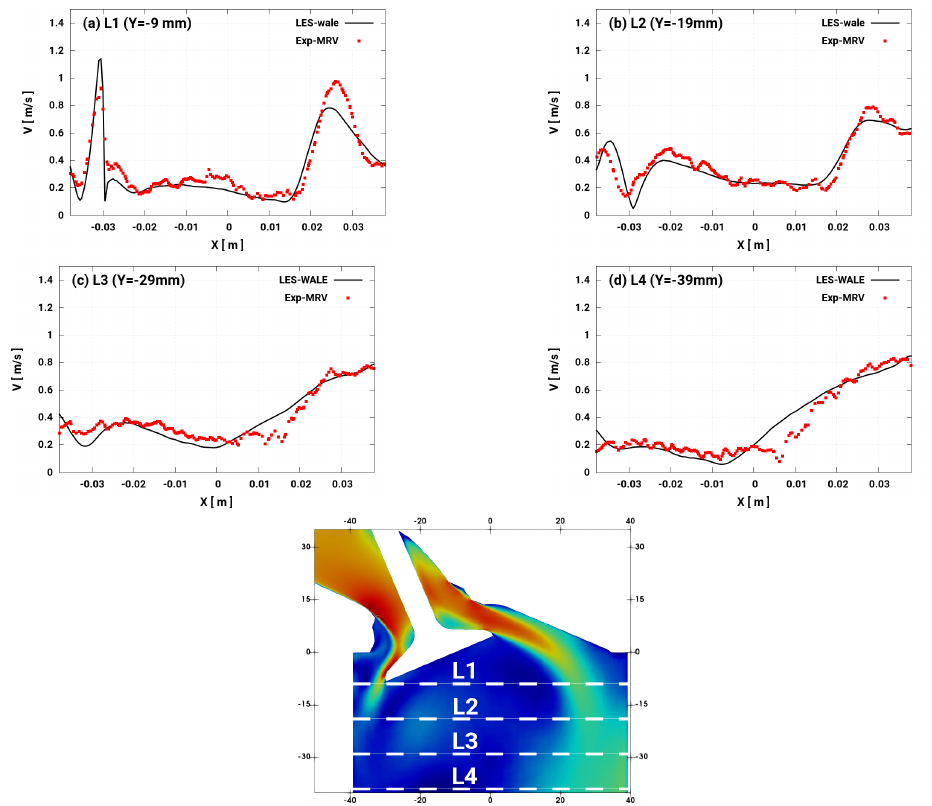
Figure 11. Comparison of velocity profile for LES and MRV at various locations on plane at Z = 19 mm along various lines as represented in the bottom